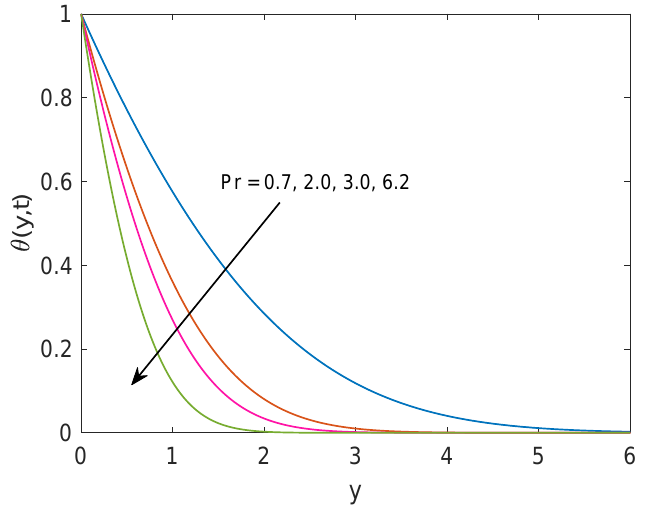
Figure 12. Temperature profile for different Pr when Q = 0.5, Nr = 1.5, φ = 0.1 and t = 0.5.